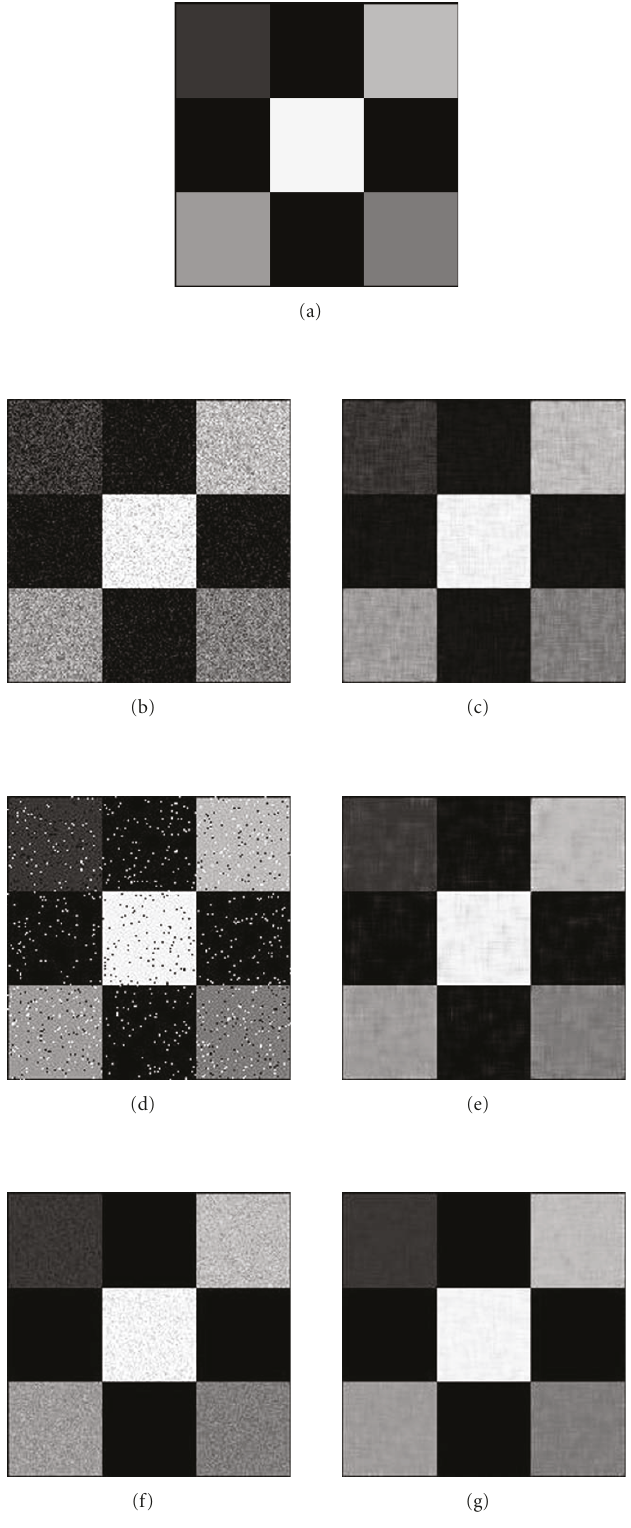
Figure 7: Comparing the performance of the various noises on “Nine Square Regions”. (a) Original Image. (b) Gaussian noise image, σ = 0 . 01. (d) Salt and Pepper noise image, noise density is 0.05. (f) Poisson noise image, (c), (e), and (g) The proposed procedure denoised by (b), (d),